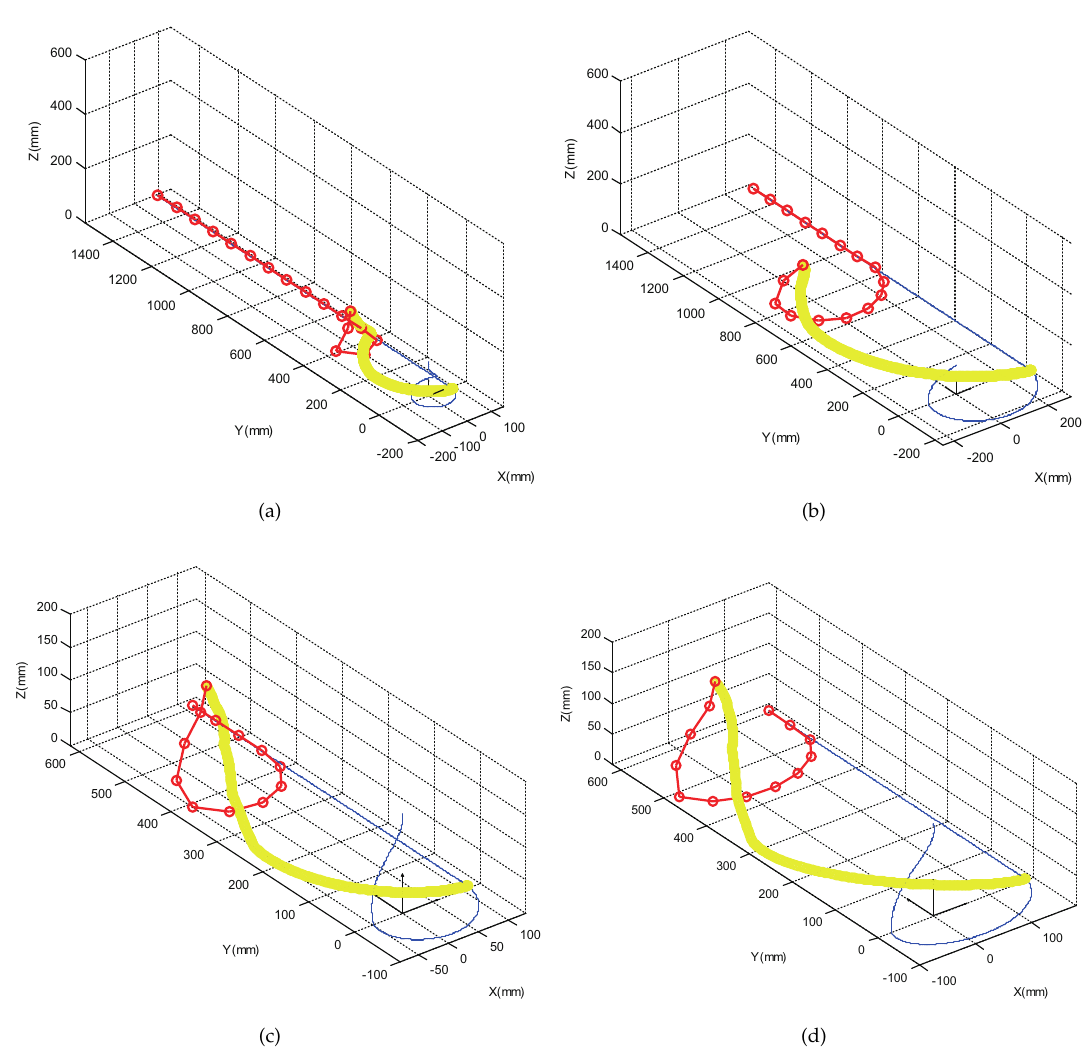
Figure 12. Head-raising motion process with different parameters of the predefined spiral curve, and the parameters are listed in Table